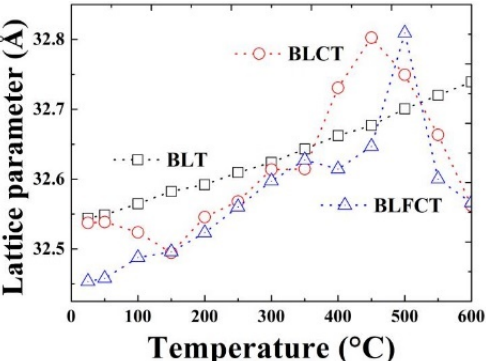
Figure 6. Out-of-plane-lattice parameters versus temperature for BLT (0 0 16), BLCT (0 0 16), and BLFCT (0 0 16) grown on the Nb-STO substrate.